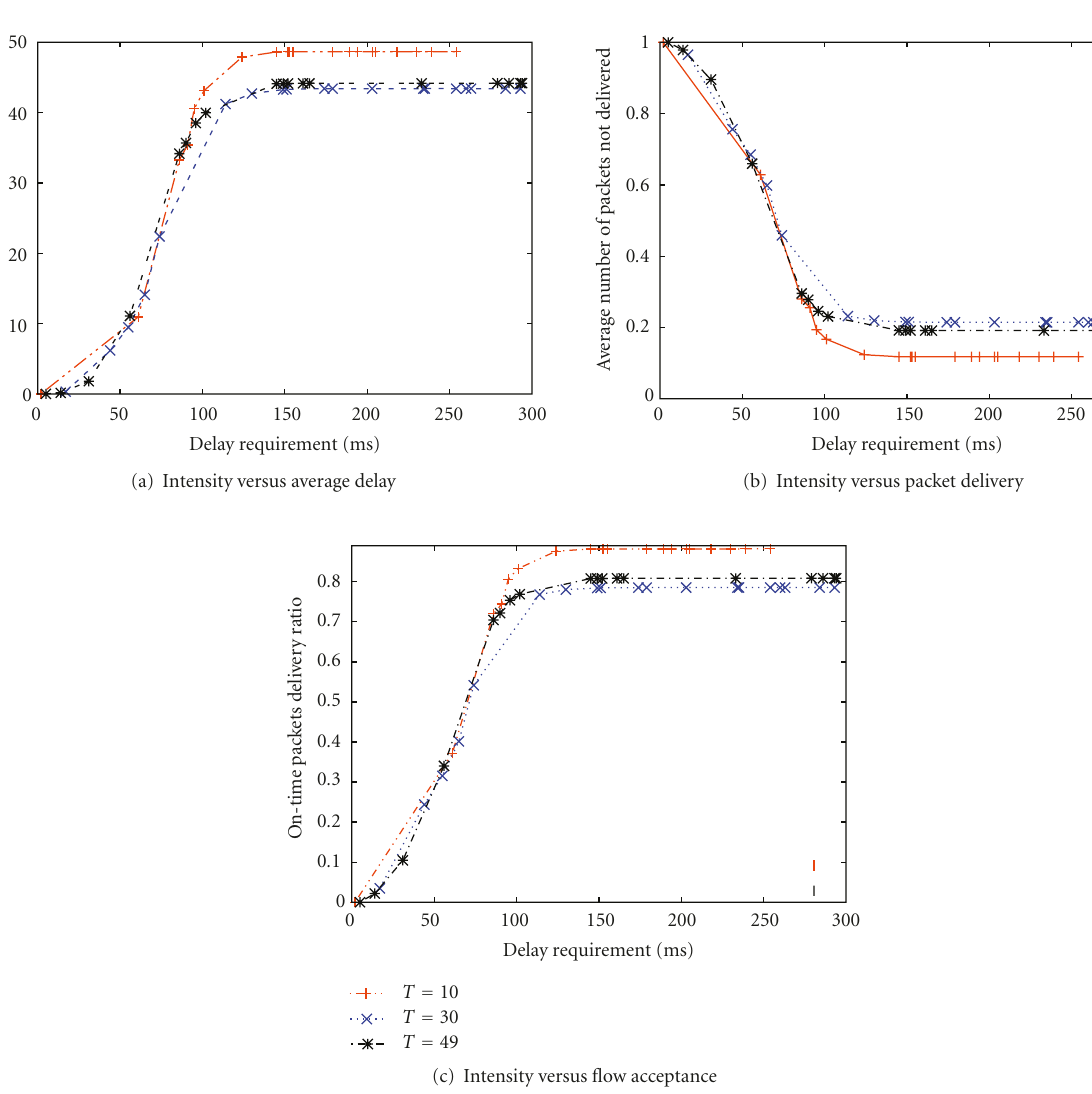
Figure 9: The impact of sensing intensity on TE